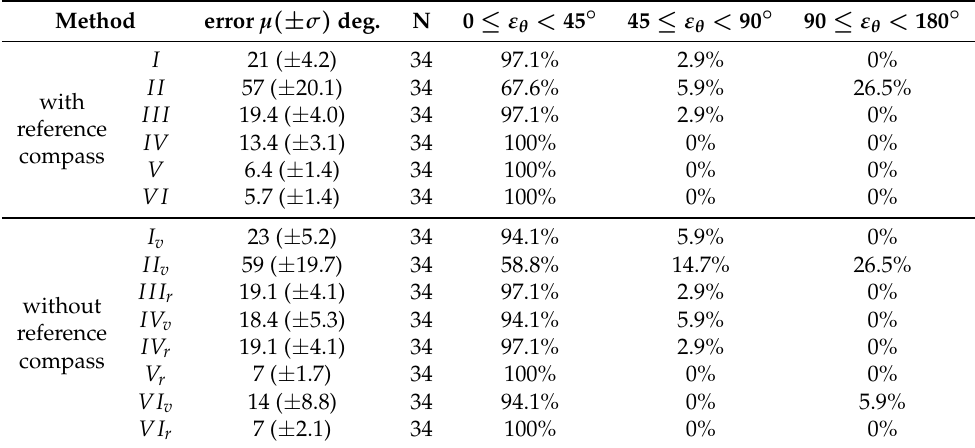
Figure 16. Homing performance with a reference compass and without a reference compass; the x-axis indicates testing methods described in Table 1: ( a ) angular errors in the indoor environment env 0; ( b ) angular errors in Vardy’s image set; error bars indicate 95% confidence intervals by assuming a t -distribution. Table 2. Angular errors with various methods for the indoor environment env0 ; testing methods are described in Table 1 ( N is the number of testing points, µ the average of angular errors, σ the 95% confidence interval (assuming a t -distribution)).